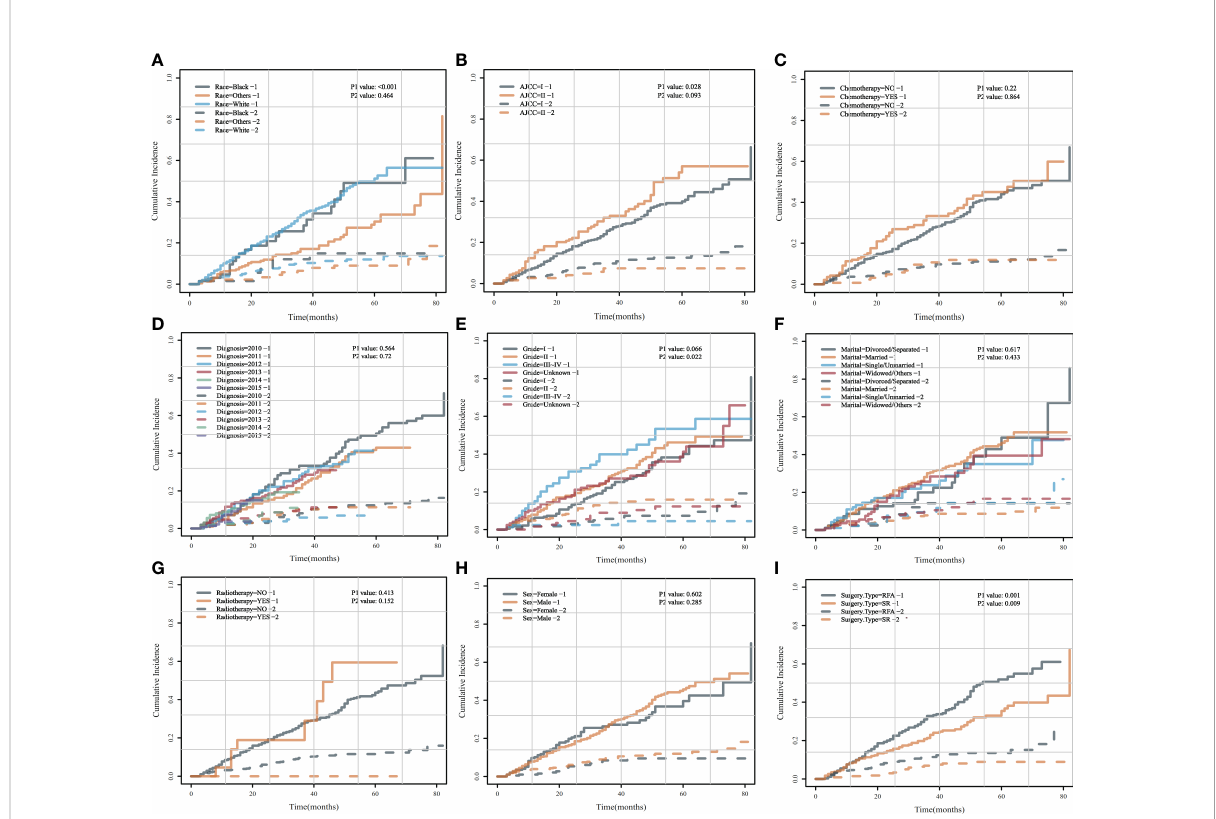
FIGURE 7 Cumulative incidence curves for each characteristic after PSM.AHCSD/OCSD cumulative incidence curves in HCC patients of different races (A) , AJCC (B) , chemotherapy (C) , diagnosis (D) , grade (E) , marital (F) , radiotherapy (G) , gender (H) , surgery type (I) group with SR or SFA after